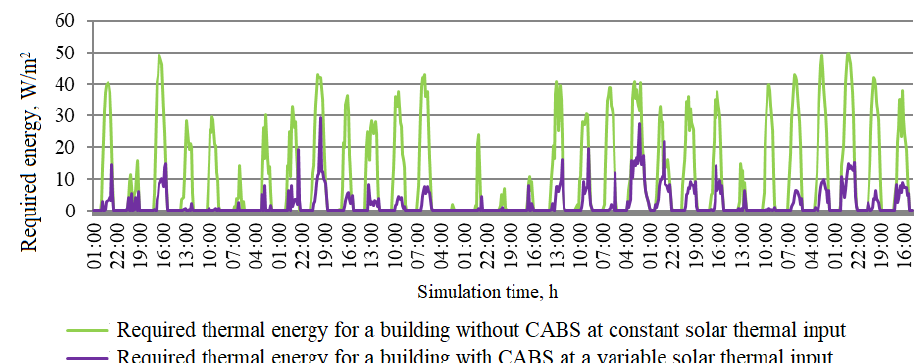
Fig. 3. Required energy with and without CABS in July